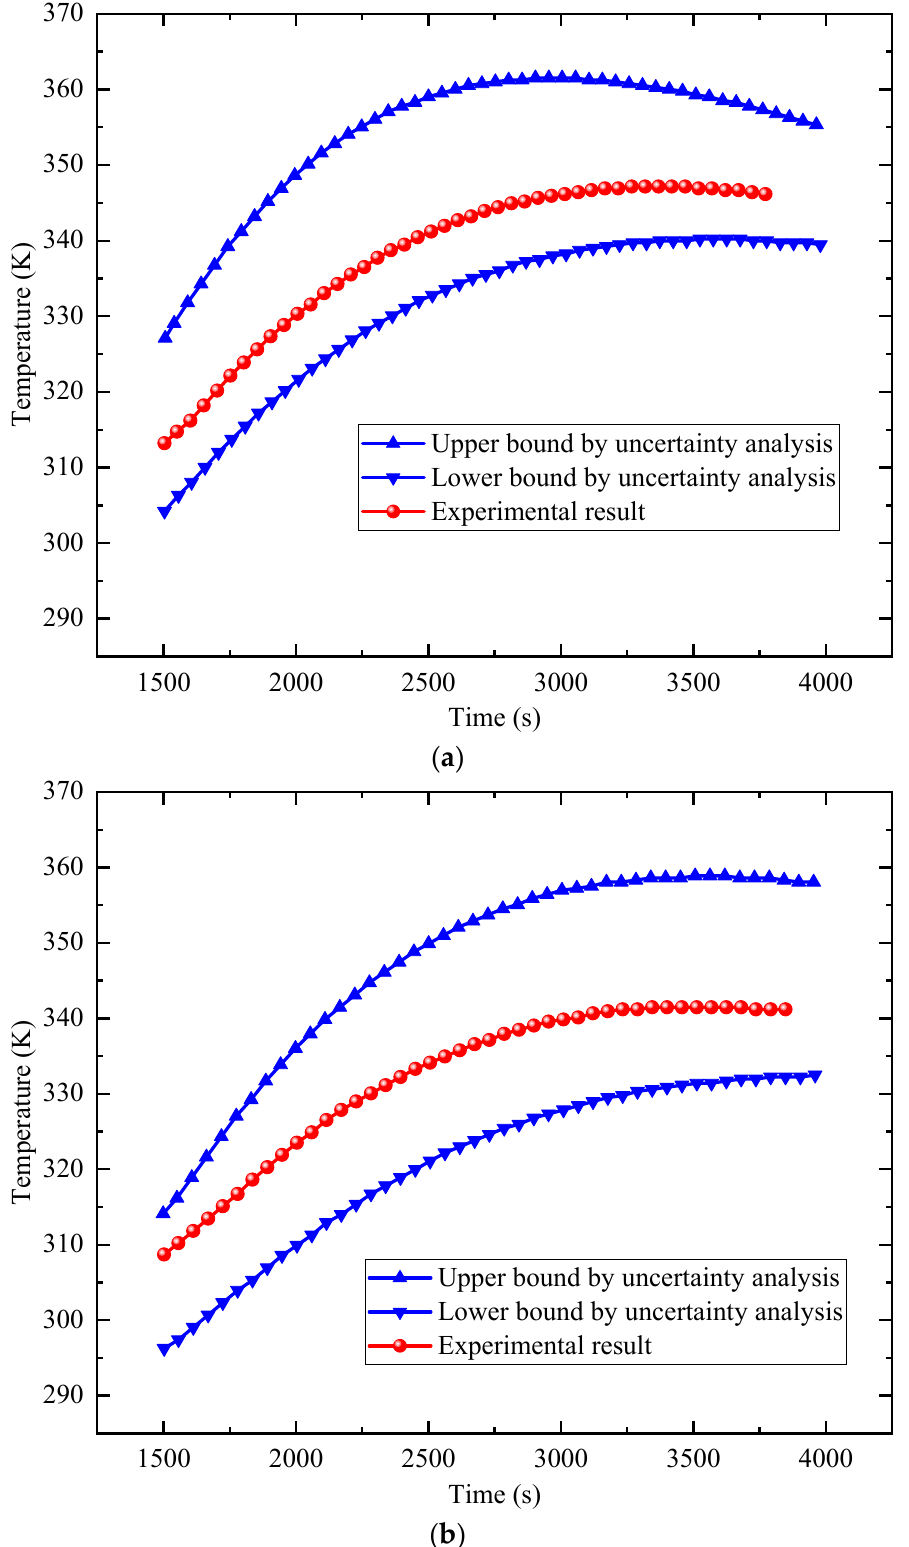
Figure 11. Temperature results obtained from uncertainty analysis method and experiment for the thermal protection tiles. ( a ) The initial tile; ( b ) The optimized tile.